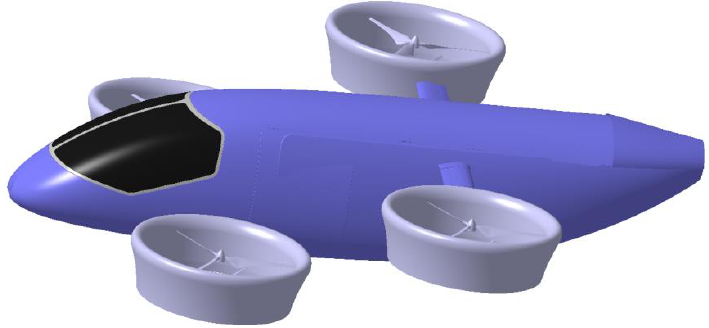
Figure 1. eVTOL aircraft with DCP rendering.